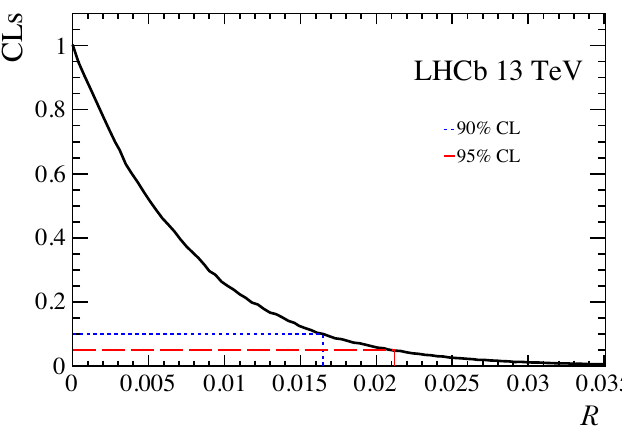
Figure 5 . The scores from the CLs method for each value of the assumed ratio of branching fractions . Observed values are shown by the solid black line. The set upper limits at 90% and R 95% CL are indicated by the dotted (blue) line and the dashed (red) line,